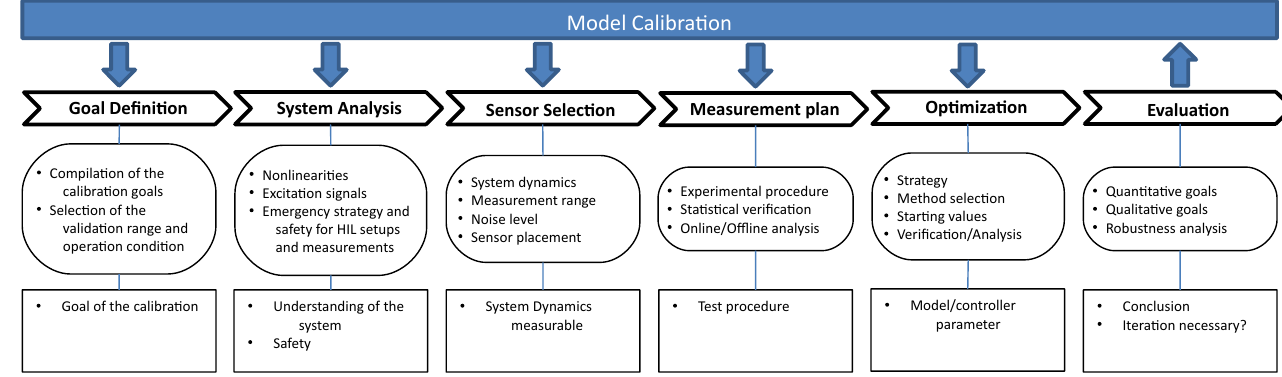
Figure 5. Overview for the Modelica model calibration process using measurement